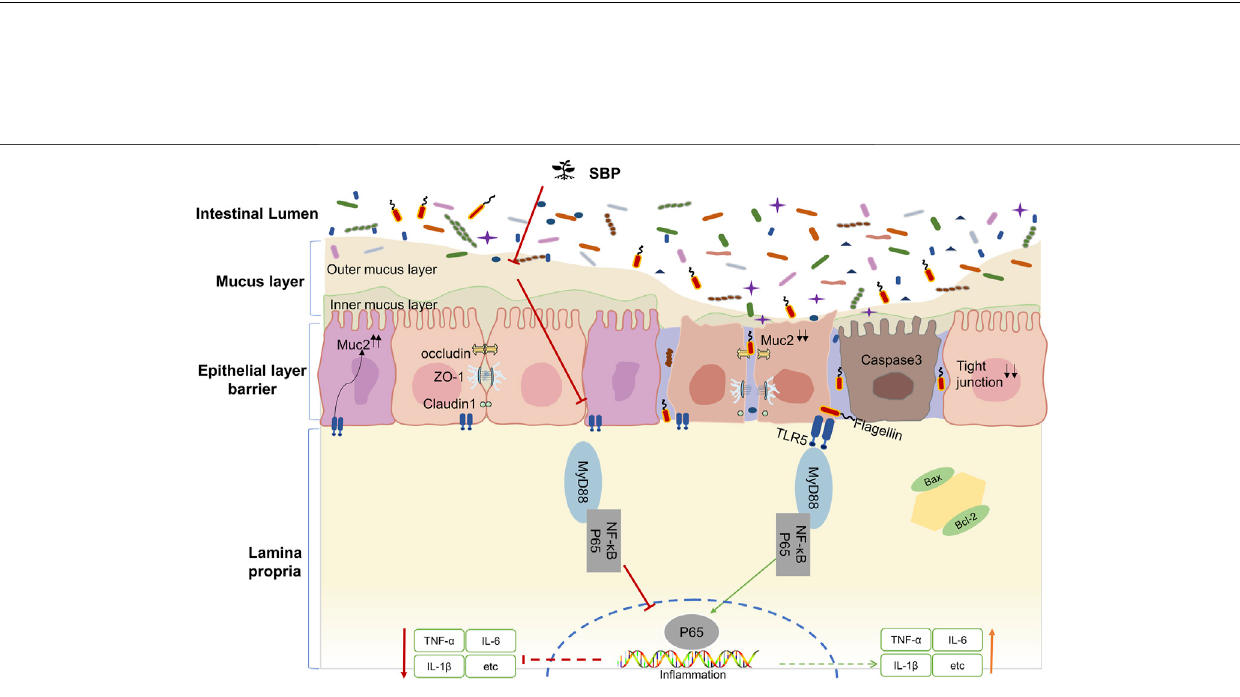
Frontiers in Pharmacology |